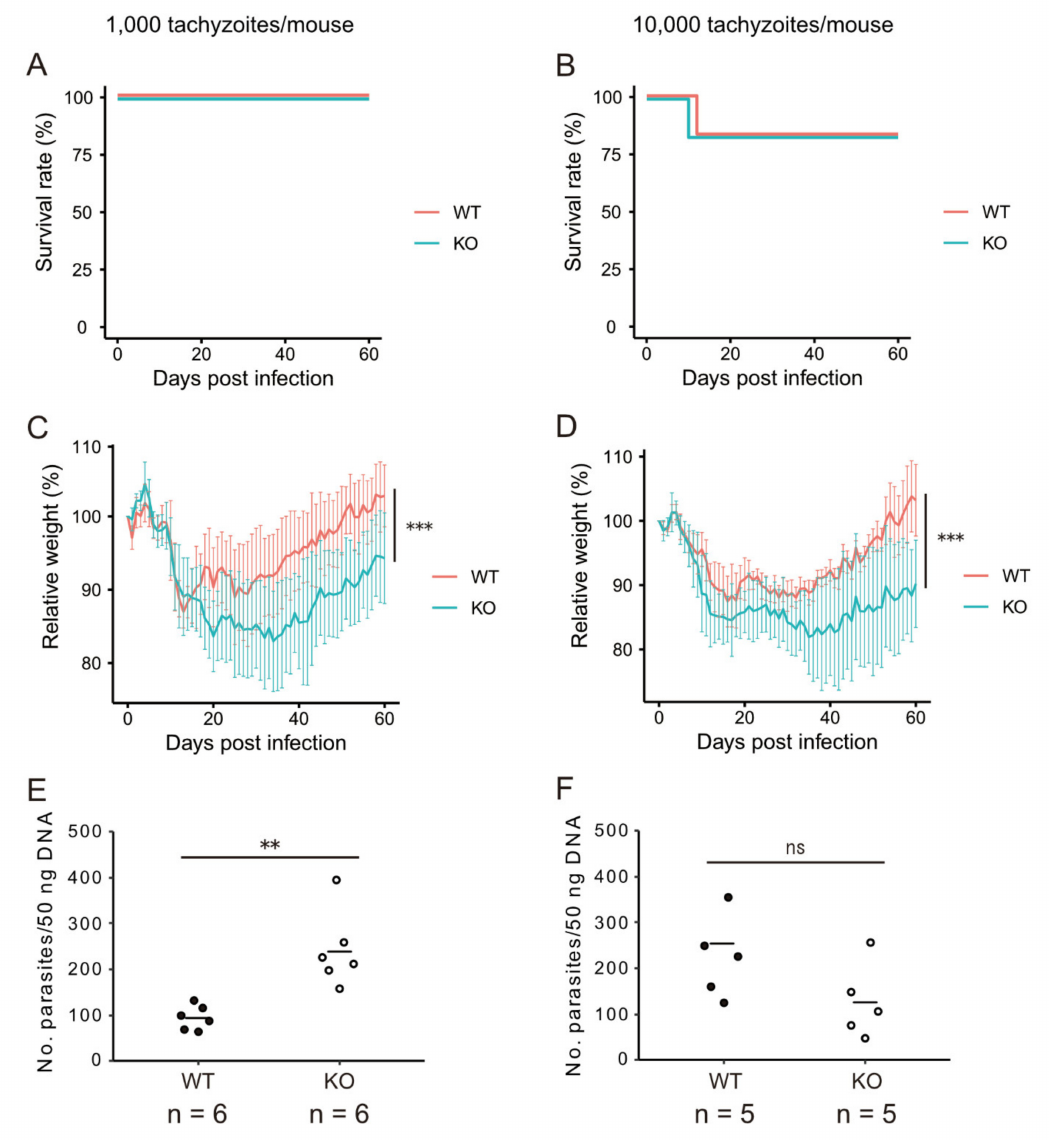
Figure 1. Survival, body weight changes and brain parasite burden in WT and CXCR3KO mice infected with T. gondii . WT and CXCR3KO mice ( n = 6 per group) were intraperitoneally injected with 1000 ( A , C , E ) or 10,000 ( B , D , F ) tachyzoites